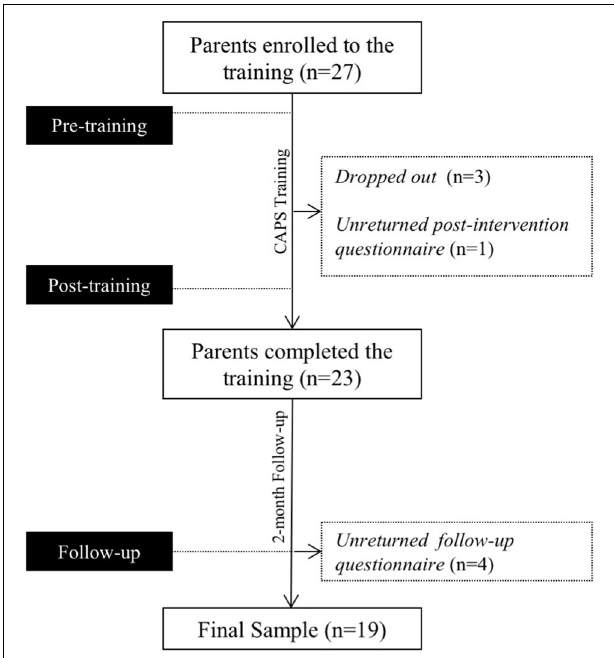
FIGURE 1 | Participant flow of the